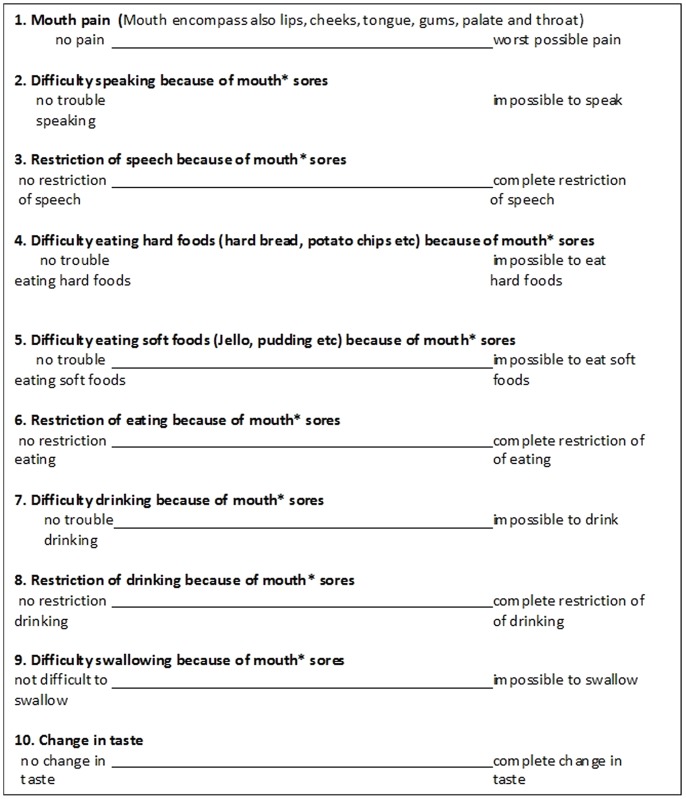
PROMS scale questionnaire with the ten components each detailing two extremes of a functional characteristic within a 100(VAS) (23).